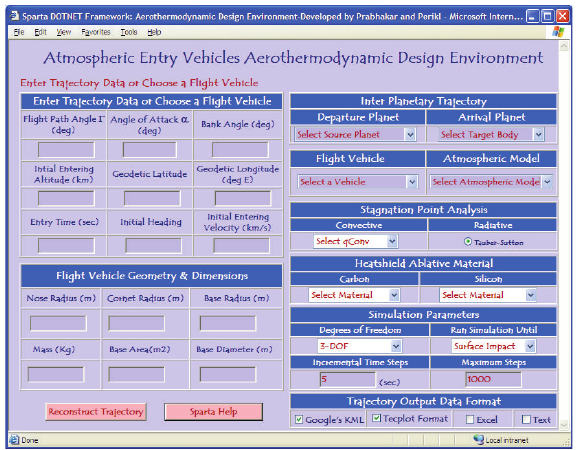
Figure 11: Sparta DOTNET framework user interface.